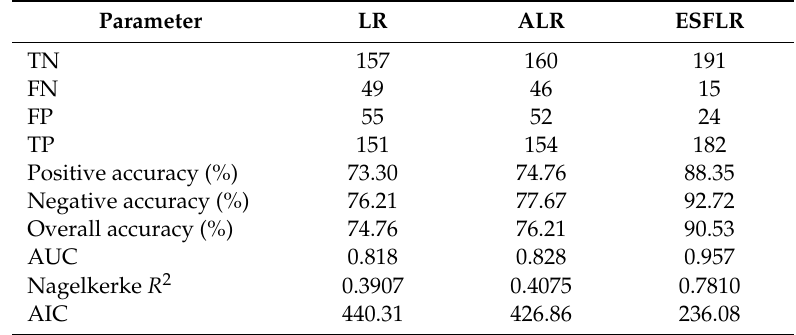
Table 8. The performance metrics of three regression